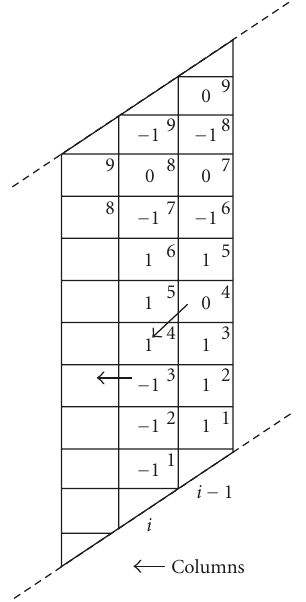
Figure 9: Tag values ( − 1, 0, 1) arranged in columns and indexed from 1 to D (here D = 9) for the backtracking stage. Arrows indicate exit and entry in successive